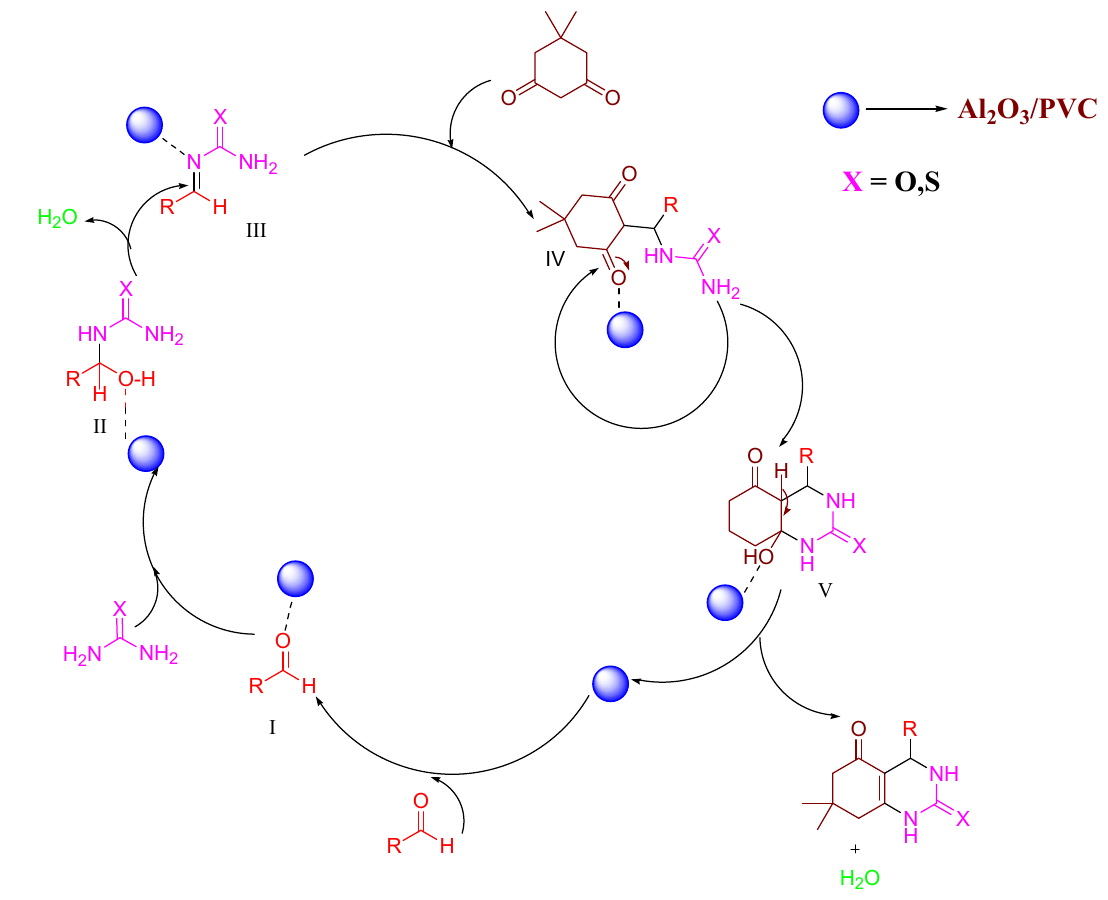
Figure 7. A proposed mechanism for the synthesis of octahydroquinazolinone derivatives using Al 2 O 3 /PVC catalyst.